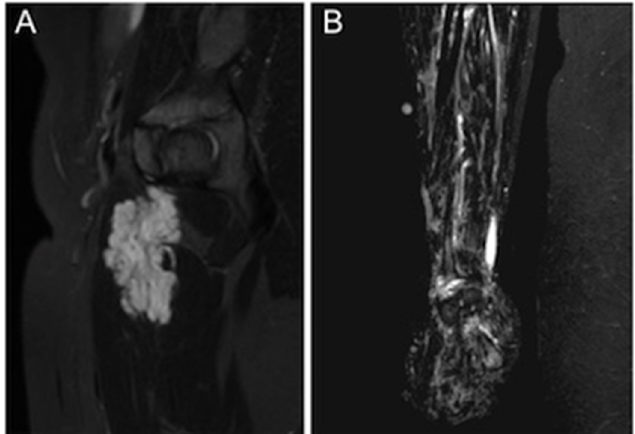
Figure 1. An example of the two different morphological appearances of VMs in MRI. ( A ) A discrete and well-demarcated VM in the thigh muscles. ( B ) A diffuse VM of the right forearm. Laboratory analyses included plasma prothrombin time (PT, %, Nycotest PT, Axis- Shield PoC As), activated partial thromboplastin time (APTT, s, Actin FSL, Dade Behring), thrombin time (TT, s, BC Thrombin Reagent, Siemens Healthcare Diagnostics), antithrom- bin (AT, %, chromogenic assay, Berichrom. Antithrombin III, Dade Behring), fibrinogen (modified Clauss method, Multifibren U, Siemens Healthcare Diagnostics), coagulation factor VIII (FVIII) activity (FVIII:C, one-stage clotting assay, Pathromtin SL, Dade Behring and FVIII Deficient Plasma), von Willebrand factor antigen (VWF:Ag with VWFag Latex